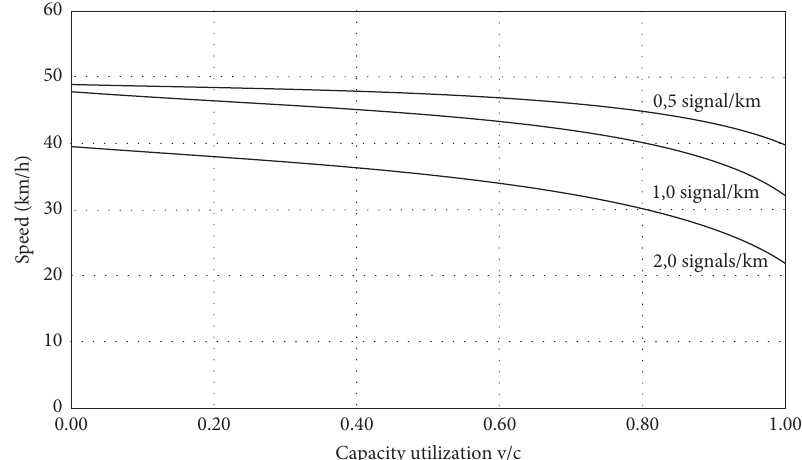
Figure 2: Speed-flow curves for the class II urban street [29].